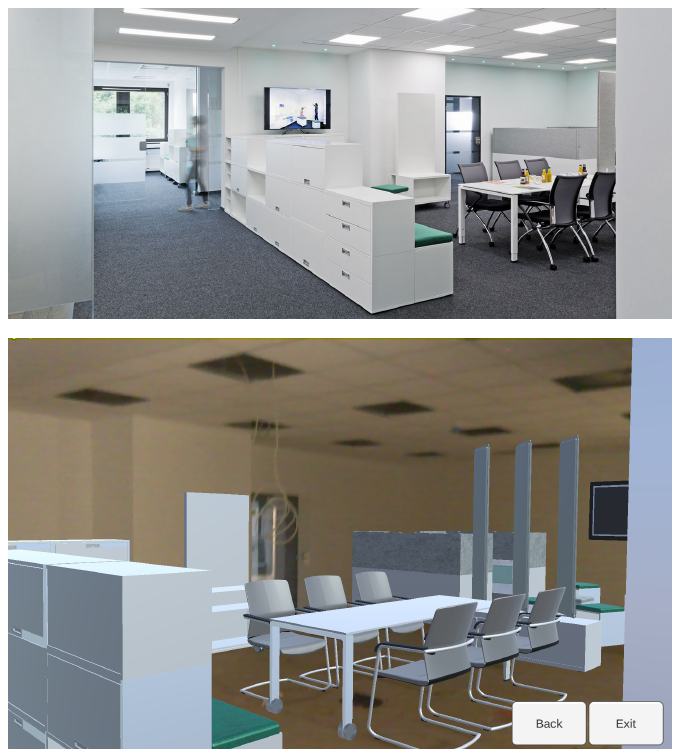
Figure 1. The location for our user study: a renovated office area with Building Information Modeling data available for the building itself, as well as the furniture. top : real furniture after the renovation, bottom : Augmented Reality visualization during